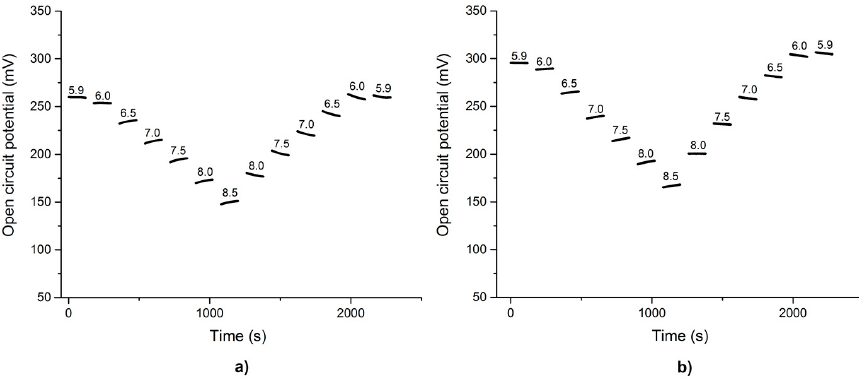
Figure 17. pH series from pH 5.9 to pH 8.5 in steps of 0.5 for an iridium oxide electrode vs. an Ag/AgCl reference electrode. For each pH measurement one minute was taken to swap the pH electrode and